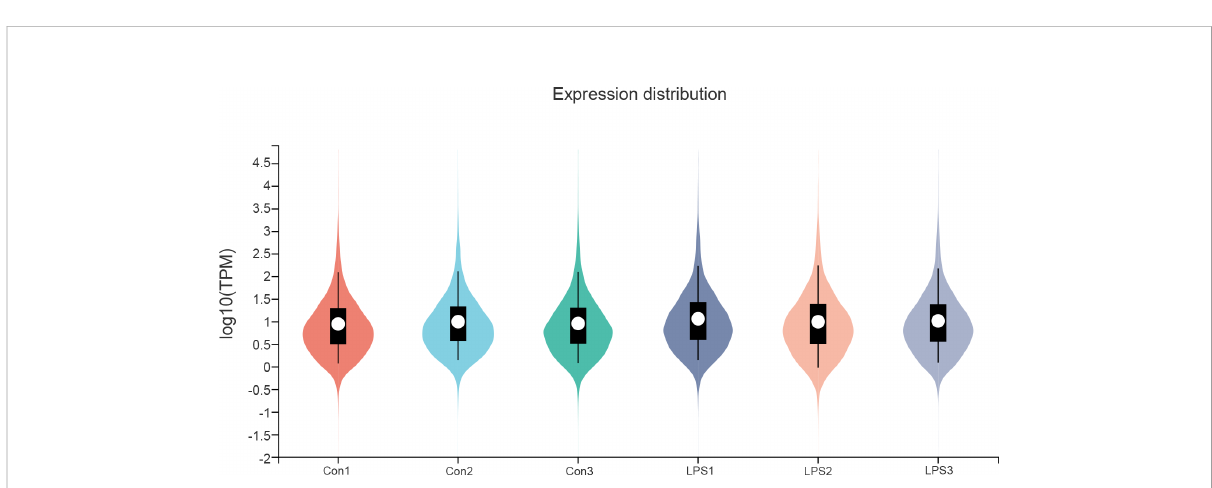
FIGURE 2 RNA sequencing data normalization for bioinformatics analysis. The violin plot shows the TPM normalization of RNA sequencing data for the control and SIMD groups.